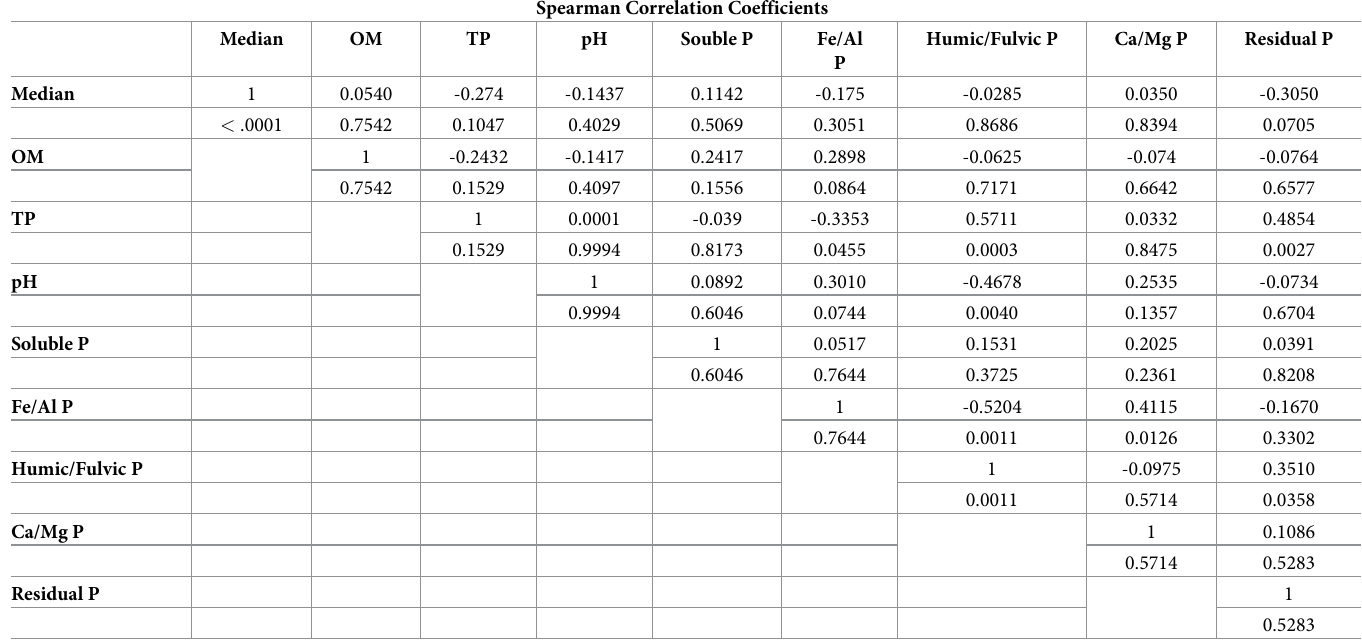
Table 4. Spearman correlation results. The top value represents the Spearman correlation coefficient, while the bottom number represents the corresponding P